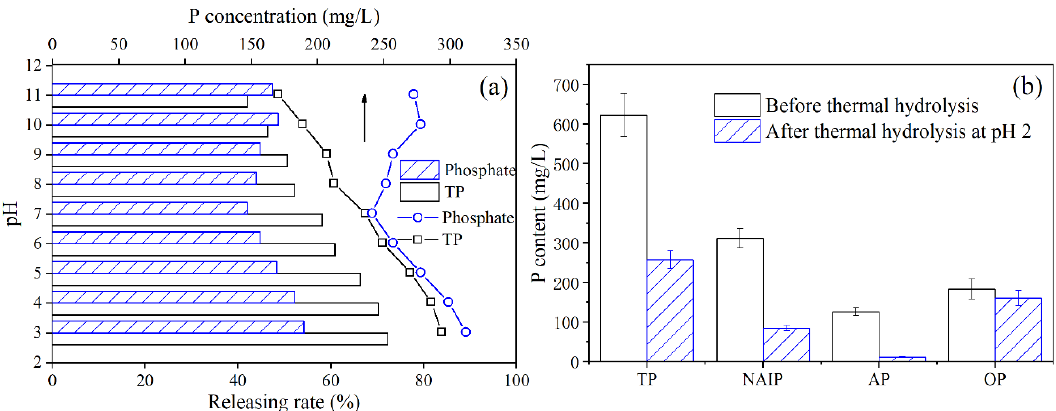
Figure 1. Effect of pH during hydrothermal treatment on P release ( a ) and change in P fraction in sludge before and after hydrothermal treatment at pH 3 ( b ). In ( a ), the lines and bars indicate the concentrations of phosphorus in the HTSS and the releasing rates, respectively.